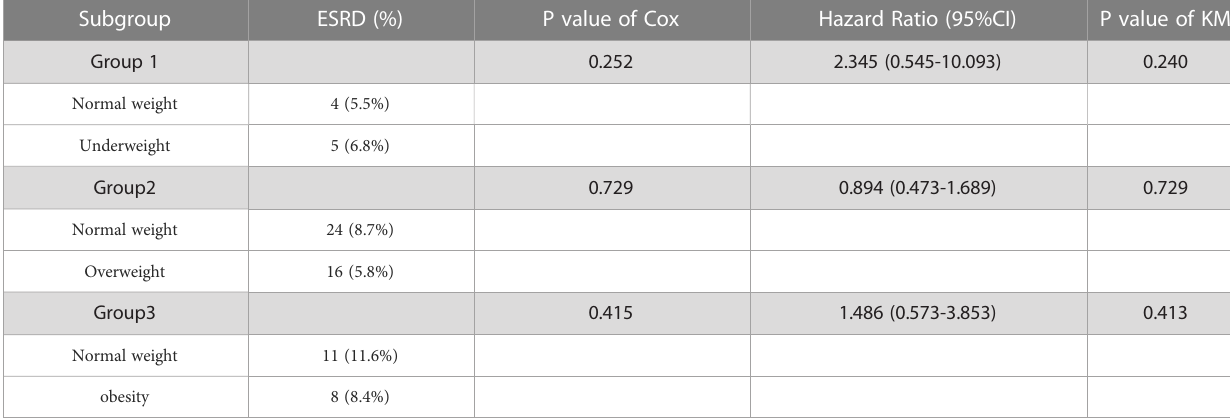
TABLE 4 The relationships between BMI and renal outcomes in the matched